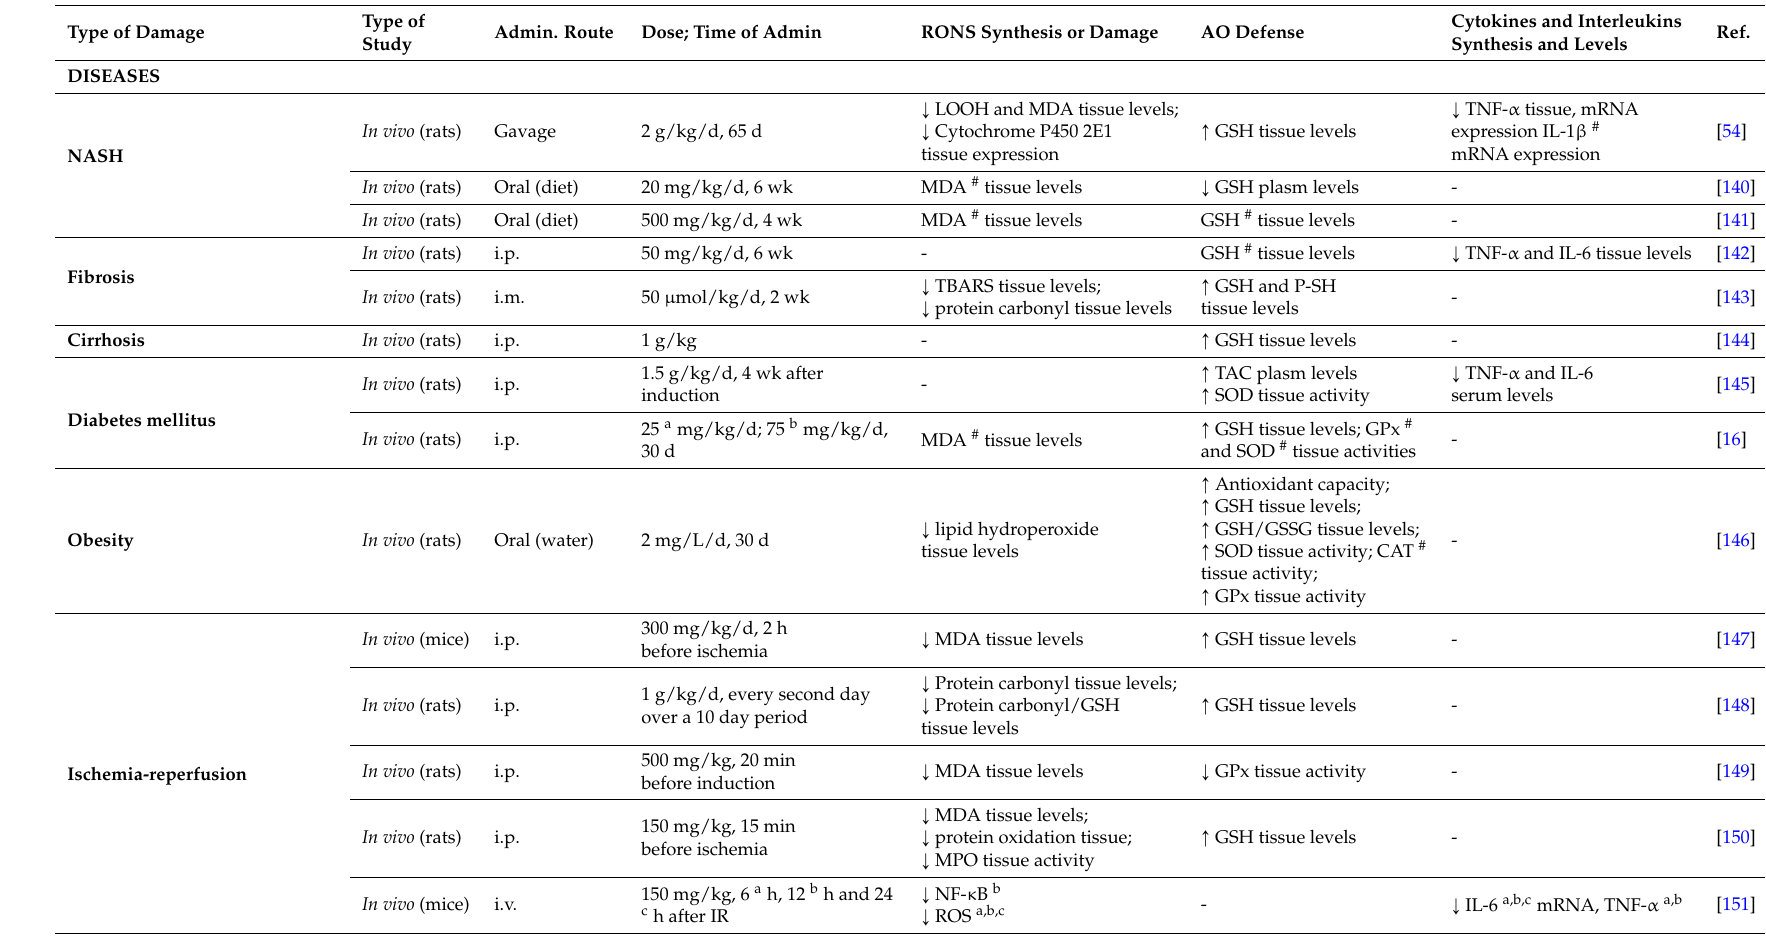
Table 2. Antioxidant and anti-inflammatory effects of N -acetylcysteine in hepatic